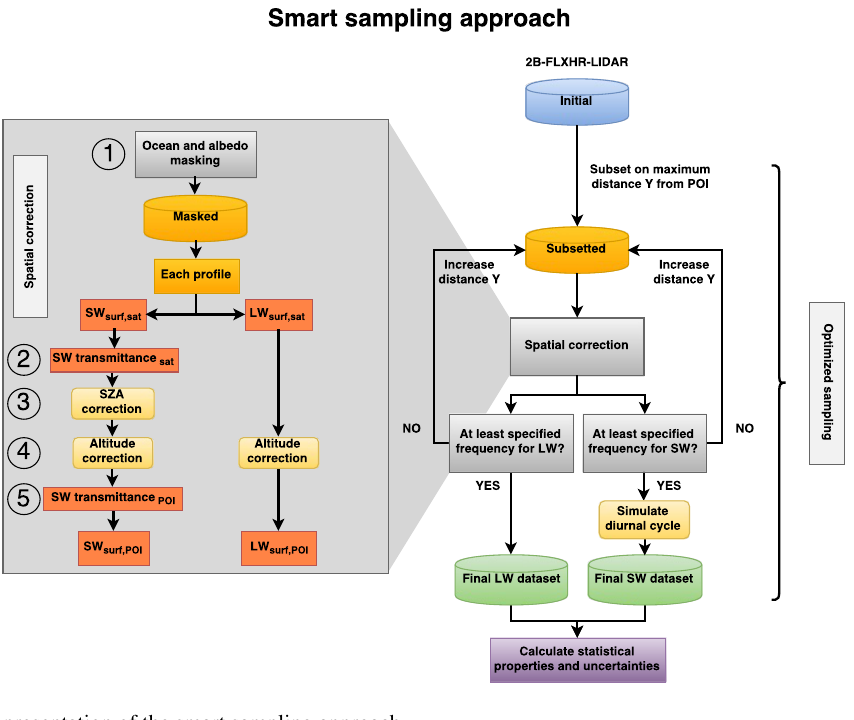
Figure 5. Schematic representation of the smart sampling approach.